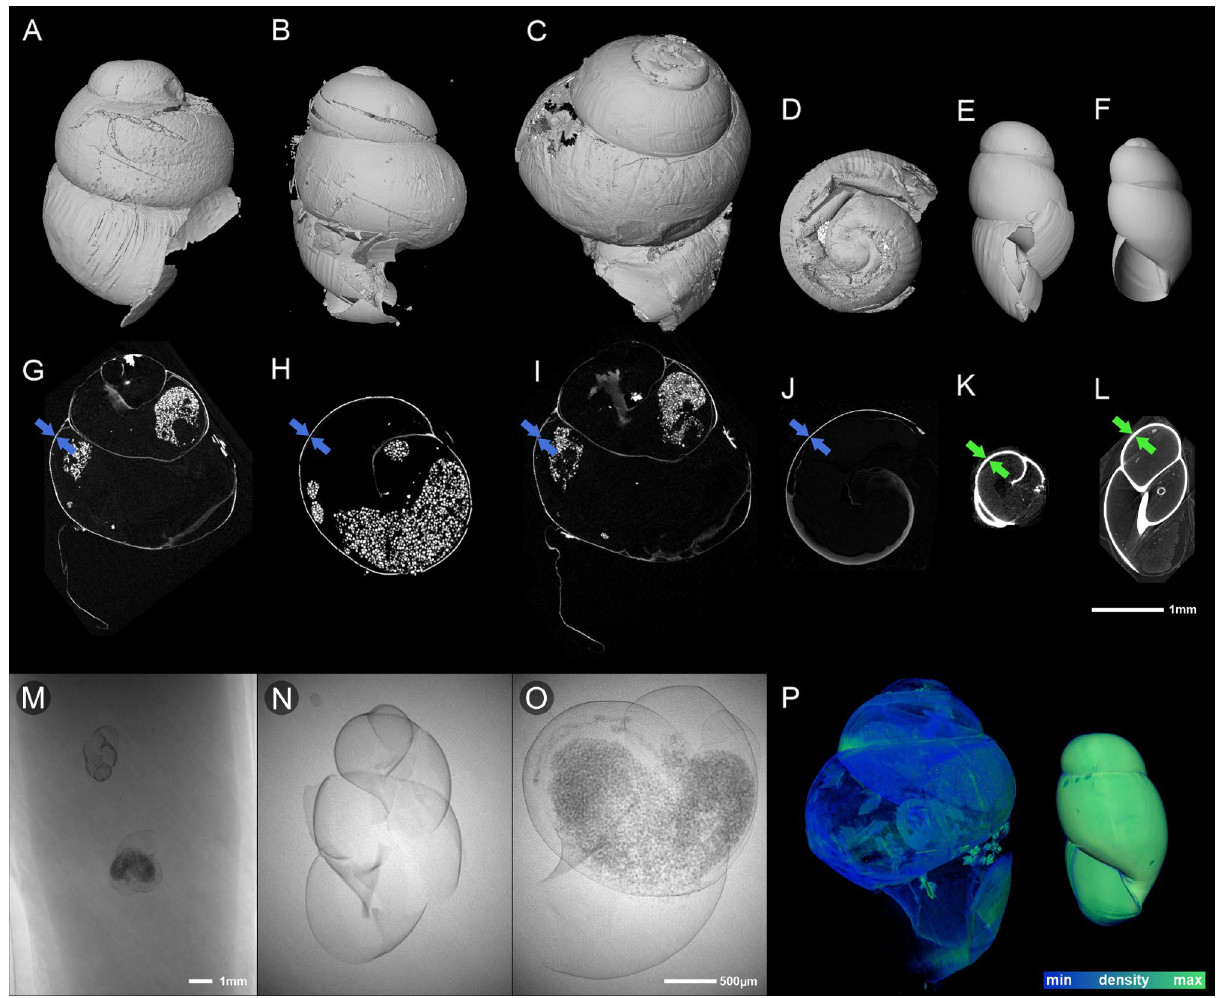
Figure 5. Comparison of embryonic shell thickness in clausiliids: ‘soft-shelled’ neonates of Z. ventriosa ( A,B,G,H ) and O. miranda ( C,D,I,J ); “hard-shelled” neonate of S. addisoni ( E,K ) and embryo of T. sheridani ( F,L ) scanned inside a parental shell. Upper row—microCT visualisation of shell surface; middle row—microCT sections of those specimens; ( M–O ) X-ray photographs of S. addisoni (embryo from dissected adult) and Z. ventriosa (neonate) enlarged in ( N,O ), respectively, showing the difference in shell density and thickness; ( P ) microCT based volume rendering of O. miranda (left) and S. addisoni (right) neonates, showing difference between relative density of their